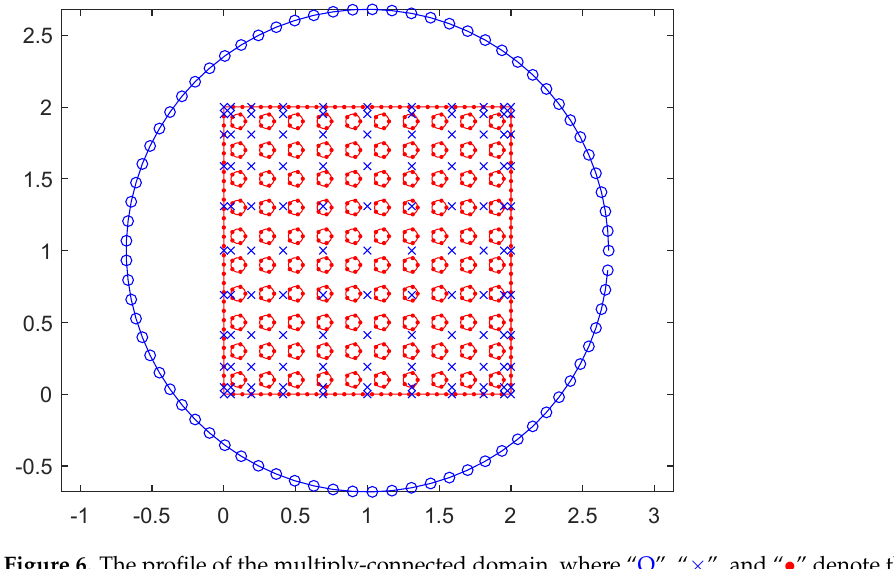
Figure 6. The profile of the multiply-connected domain, where “O”, “ × ”, and “•” denote the source points (MFS), shifted Gauss–Lobatto nodes and boundary points, respectively. Table 2. Numerical results with respect to various degrees of Fourier polynomials.